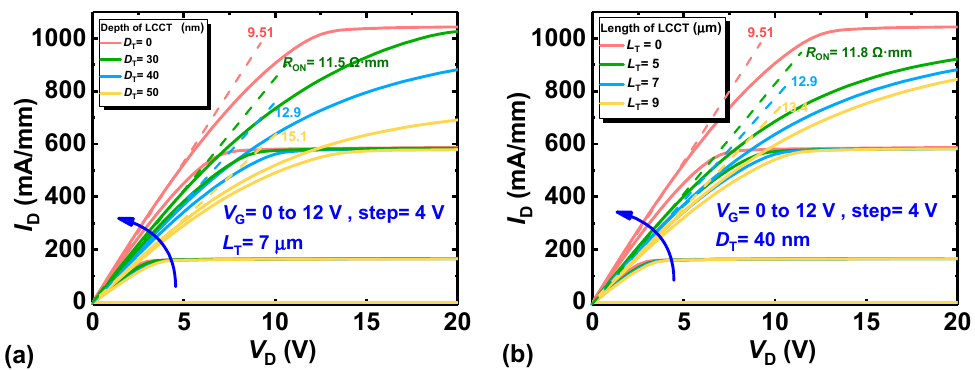
Figure 6. The output characteristics of the proposed LCCT-HEMT with different ( a ) LCCT depth and ( b ) LCCT length.